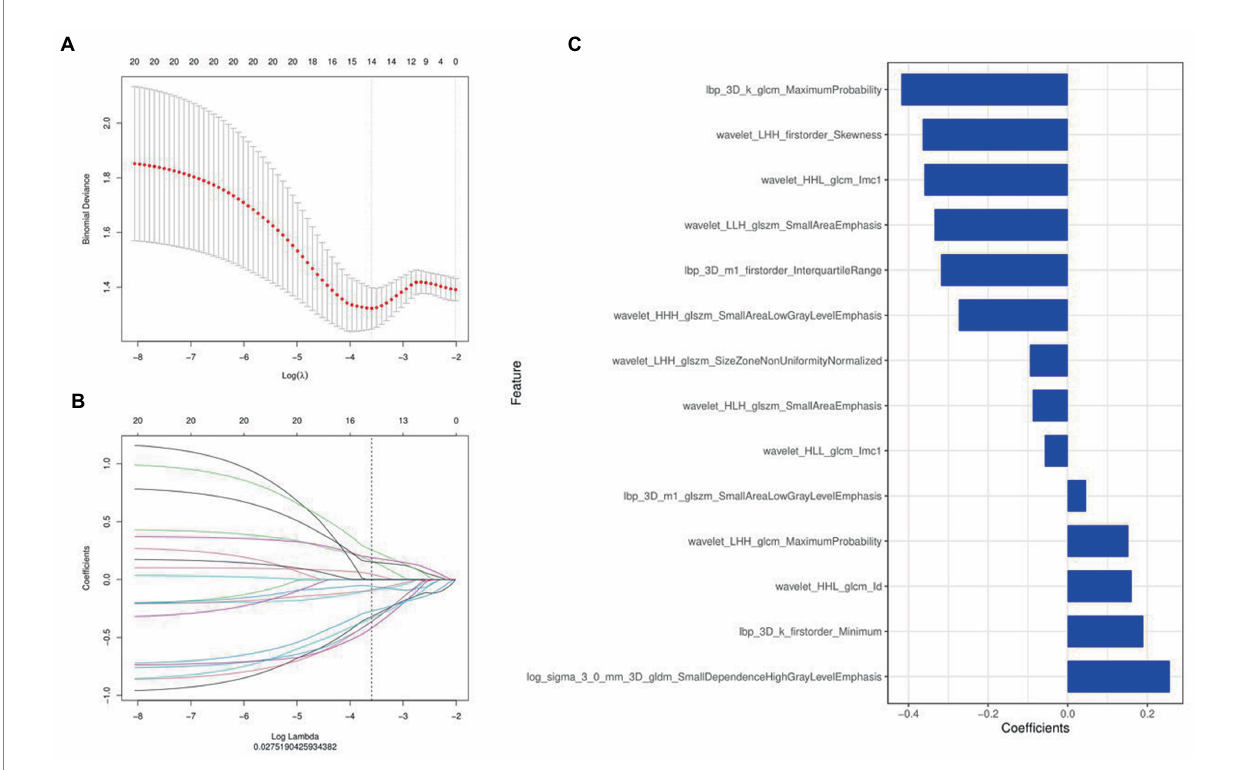
FIGURE 3 Radiomics features were selected using the least absolute shrinkage and selection operator (LASSO) regression. (A) Selection of tuning parameter ( λ ) in LASSO model. (B) LASSO coefficient profiles of radiomics features. The coefficient profiles corresponding to the selected logarithm ( λ ) values were generated by five-fold cross validation. (C) Selected radiomics features and their coefficients.